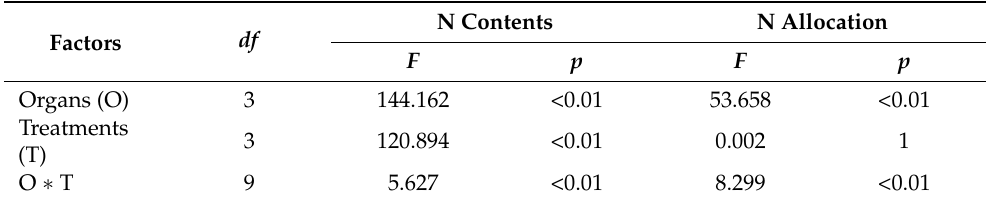
Table 1. ANOVA interaction of treatments and tissues on N contents and N allocation in buffalograss